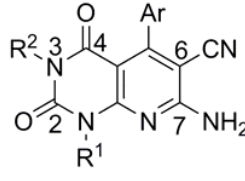
Figure 1. Structure of 7-amino-pyrido[2,3- d ]pyrimidine-6-carbonitrile